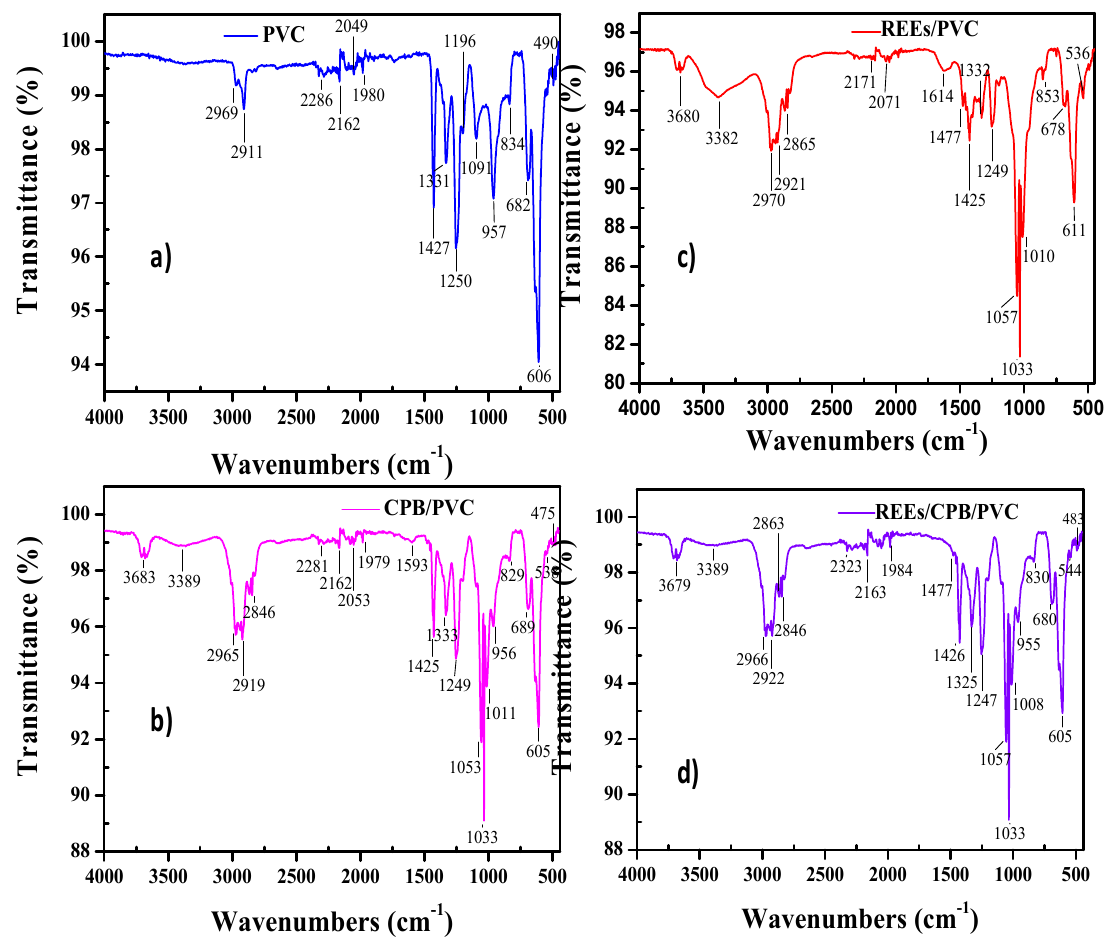
Figure 4. FTIR spectra of ( a ) PVC, ( b ) CPB/PVC, ( c ) REE/PVC, ( d ) REE/CPB/PVC.